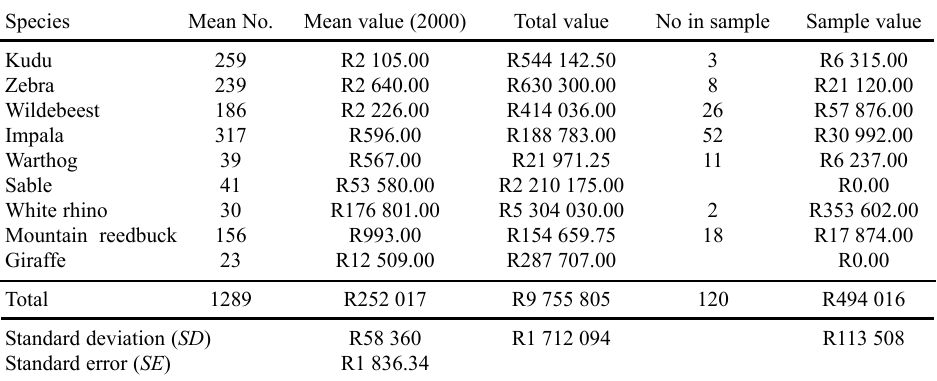
Mean number of animals counted from 4 replicate counts on Loskop Dam Nature Reserve (1991), mean Rand value (Eloff, 2000), total value and values from a random sample count of 1 hour